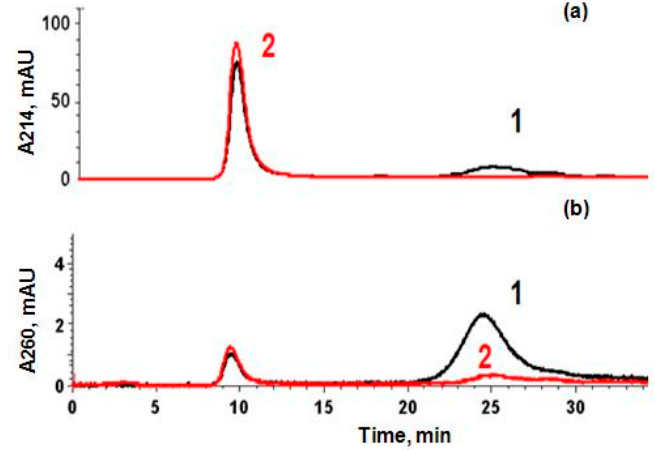
Figure 3. Elution profiles registered at 214 ( a ) and 260 nm ( b ) by analytical exclusion chromatography of commercial (black line 1) and purified (red line 2) mucins on a Biofox 17 SEC column (8 × 300 mm).